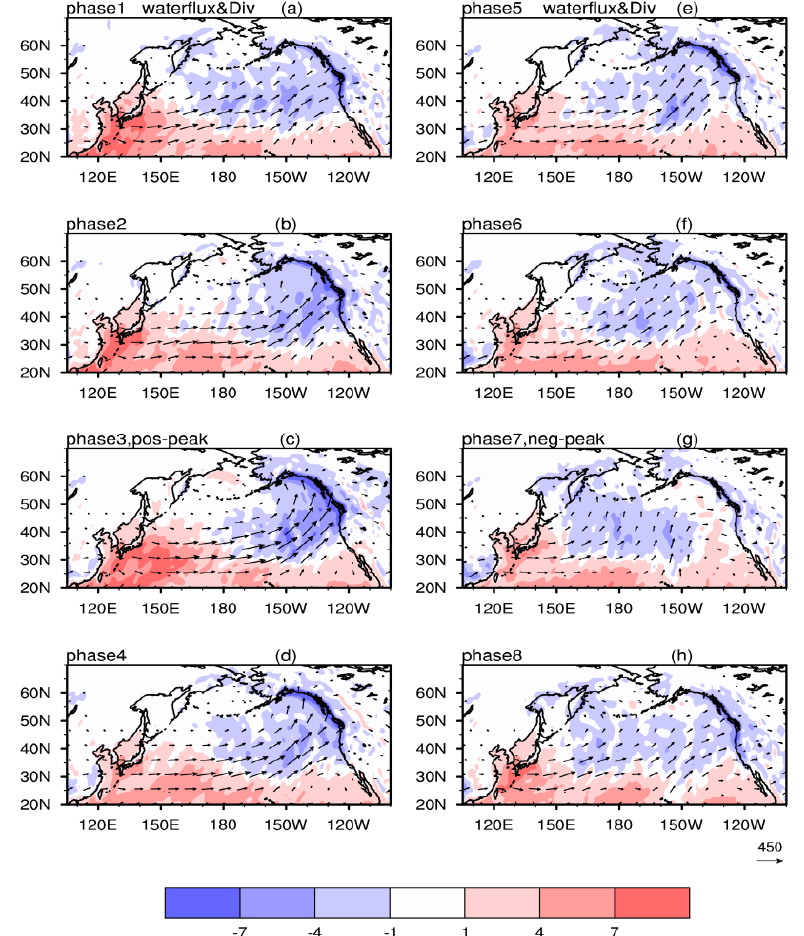
Figure 4. Life cycle composite of integrated water vapor transport (IVT, vector; kg m − 1 s − 1 ) and its divergence ( ∇· IVT, shaded areas; kg m − 2 d − 1 ) based on ALI in eight phases. ( a ) to ( h ) corresponding to phases 1 to 8.